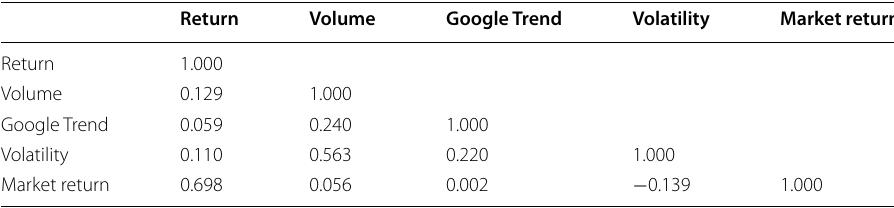
Table 2 Correlation